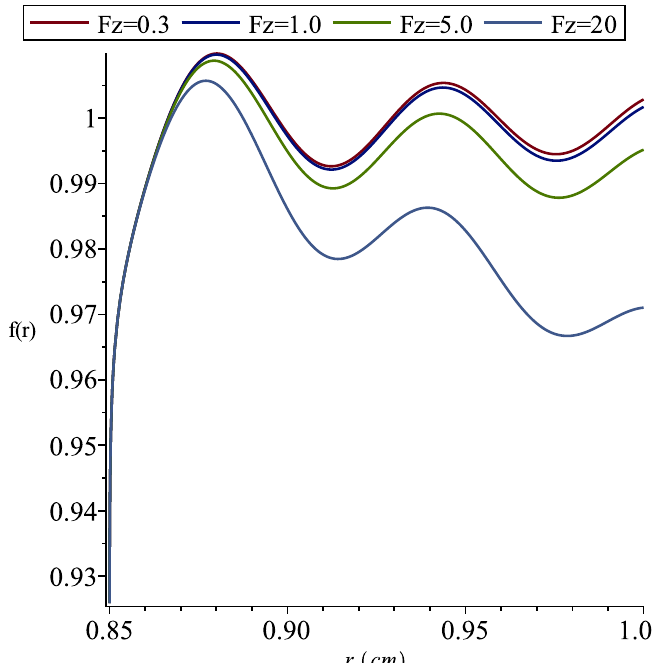
Figure 4. f versus r for α = − 10,000 in level set function φ , R i = 0.85 cm is the radial value at the gas/liquid